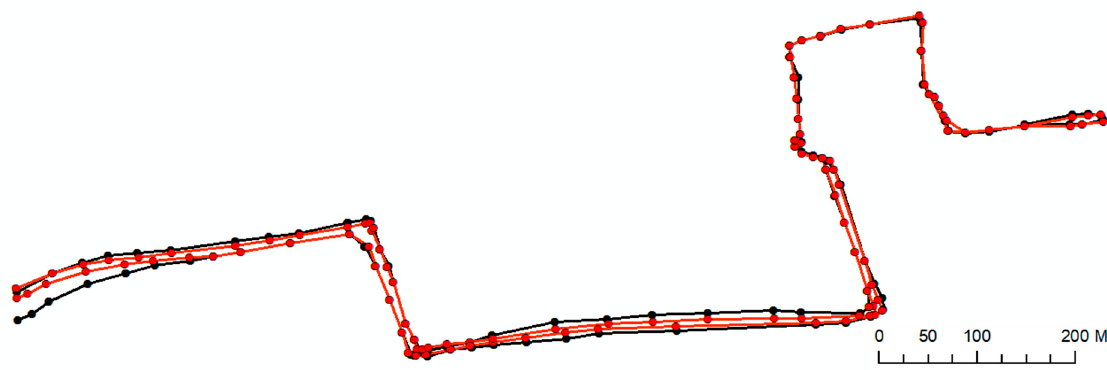
Figure 9. Comparison of the original (black) and the enhanced (red) constructed sidewalk network.